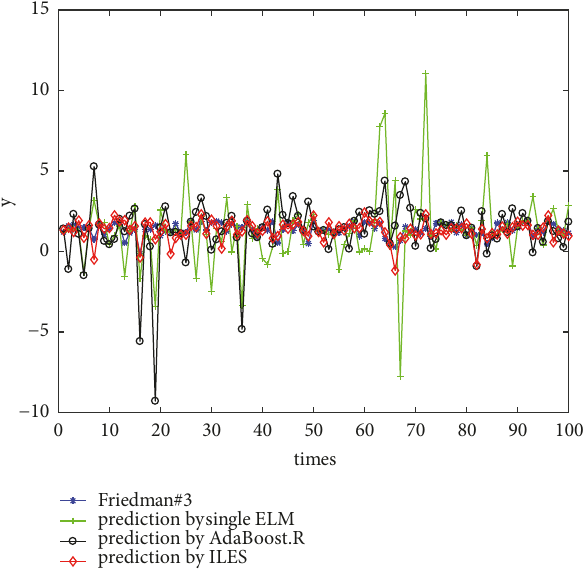
Figure 7: The comparison of Friedman#3 with different